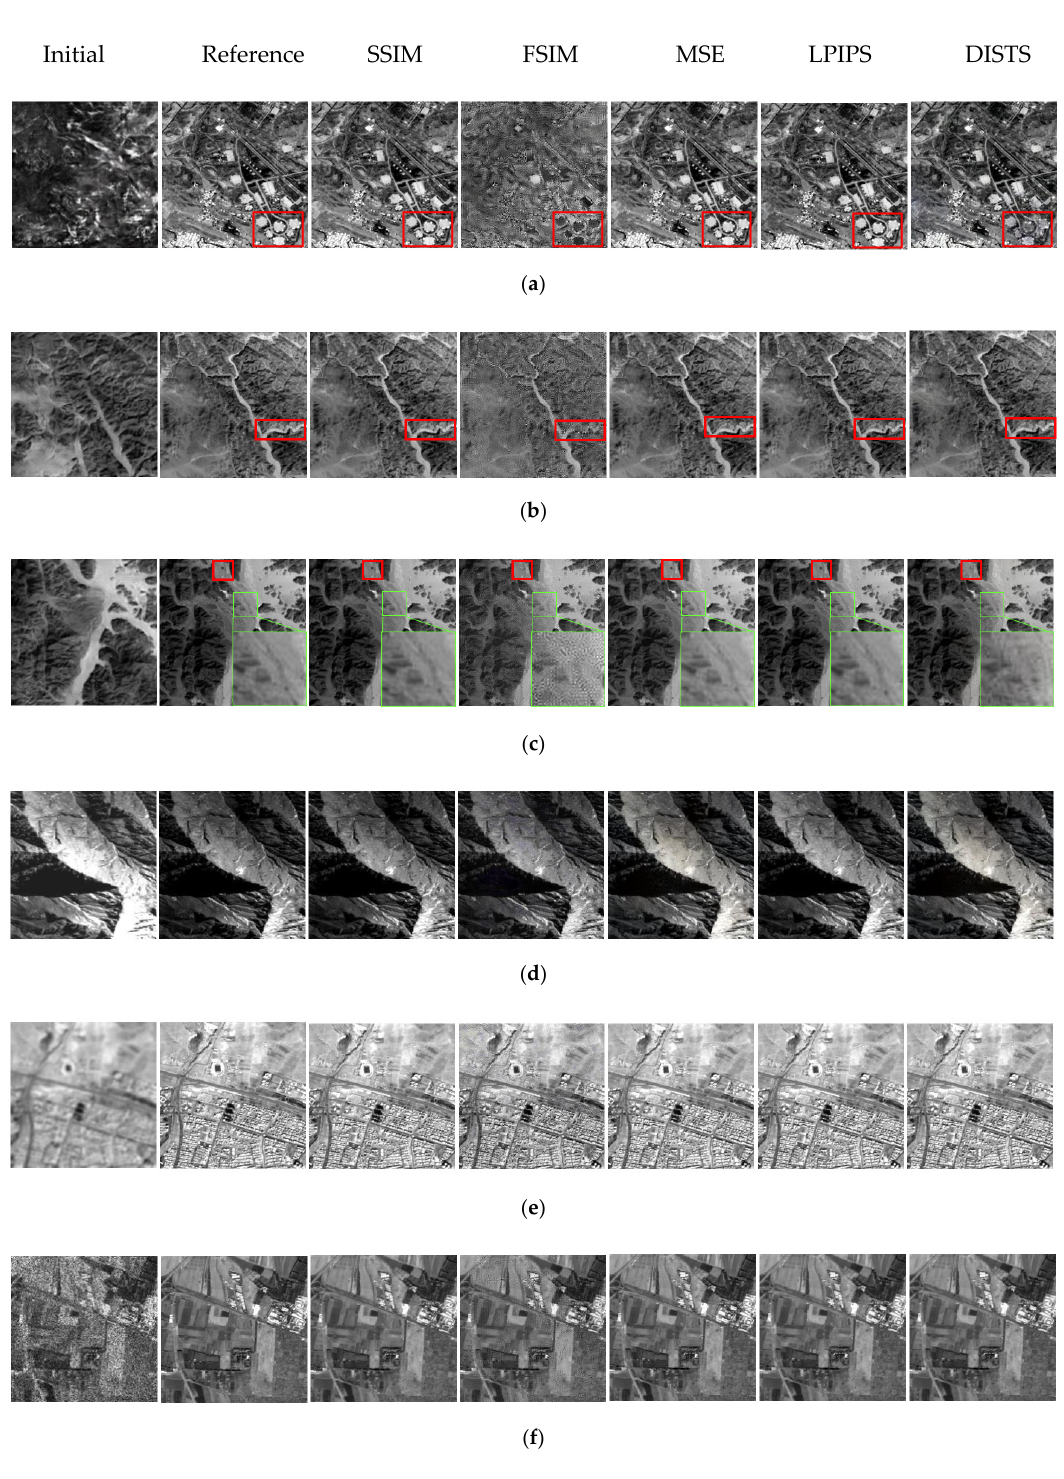
Figure 6. Distorted Image Restoration results obtained by SSIM, feature similarity (FSIM), MSE, LPIPS and deep image structure and texture similarity (DISTS). ( a ) Industrial Area with pix2pix distortion, ( b ) River with CycleGAN distortion, ( c ) Gorge with pix2pixHD distortion, ( d ) Mountain with contrast shift, ( e ) Residential area with Gaussian blur, and ( f ) Farmland with speckle noise. As shown in Figure 6, in the restoration of the GAN distorted images, point and line features